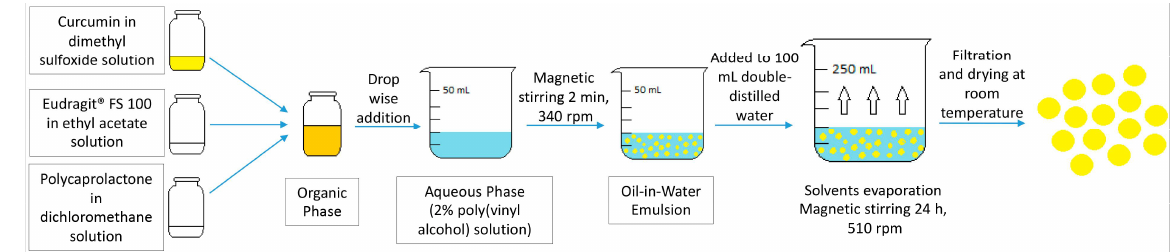
Figure 5. Col-CUR-MPs preparation